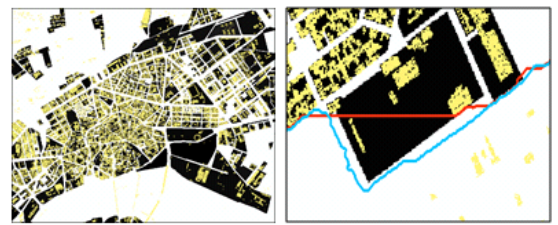
Figure 8. DEM buildings integration (Cadastre blocks in black and LiDAR buildings in yellow). River extraction only with LiDAR data (red) and with cadastre data integration (blue) Obstacles correction 1 (bridges from cartography)